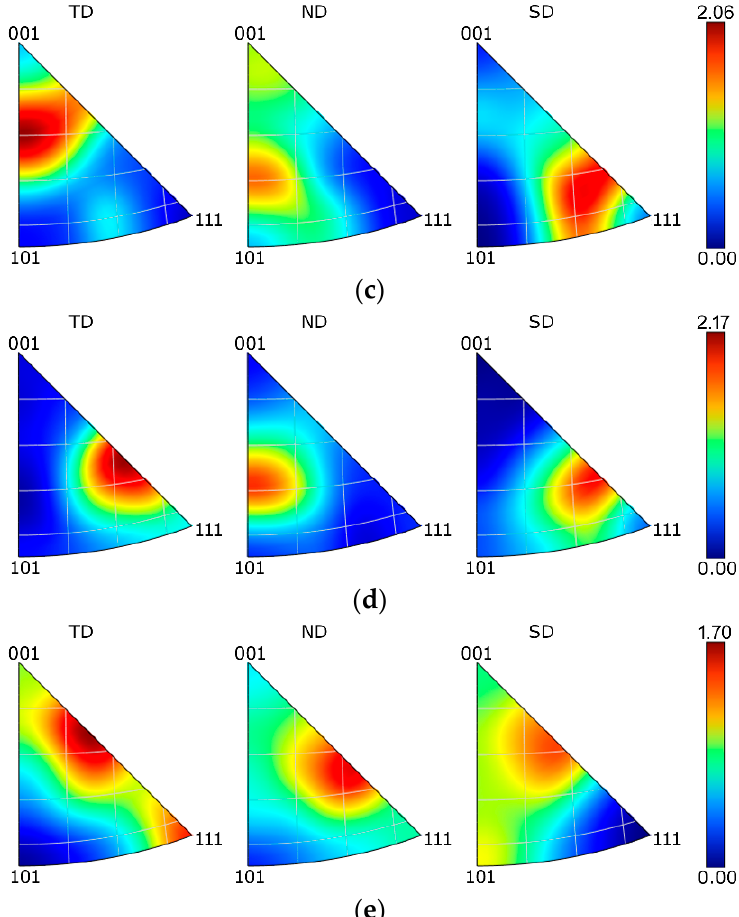
Figure 4. IPF texture images for: SLM sample ( a ); 1 sample ( b ); 2 sample ( c ); 3 sample ( d ); 4 sample ( e ).